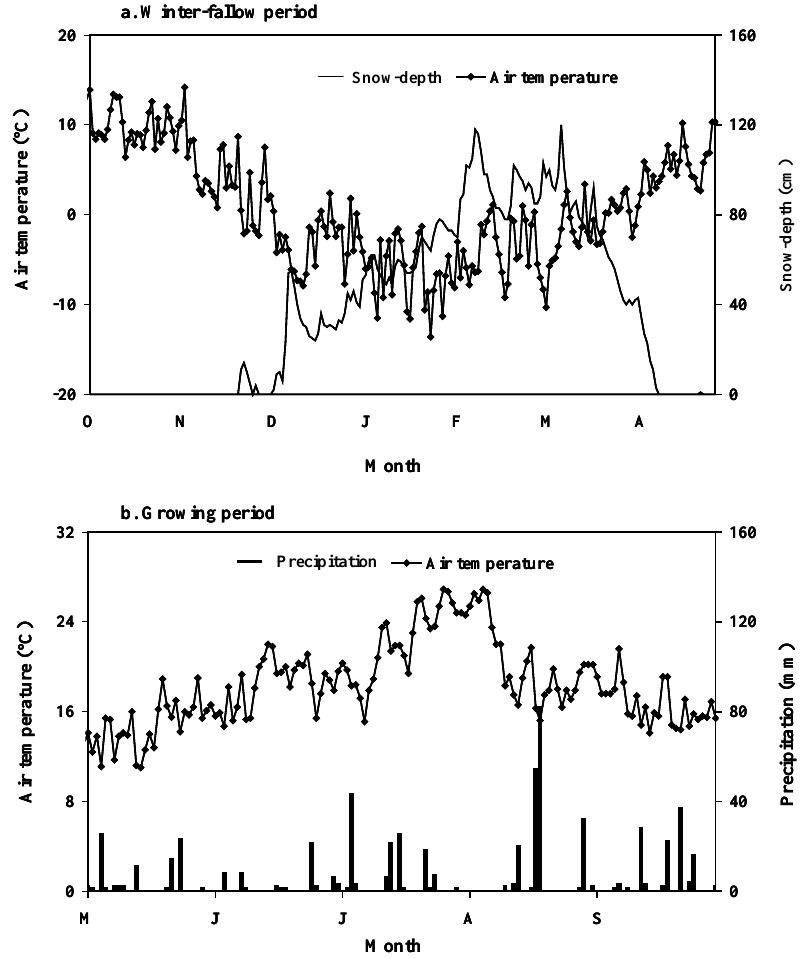
Figure 3 . Climatic conditions of investigated area during winter-fallow ( a ) and rice growing period ( b ).